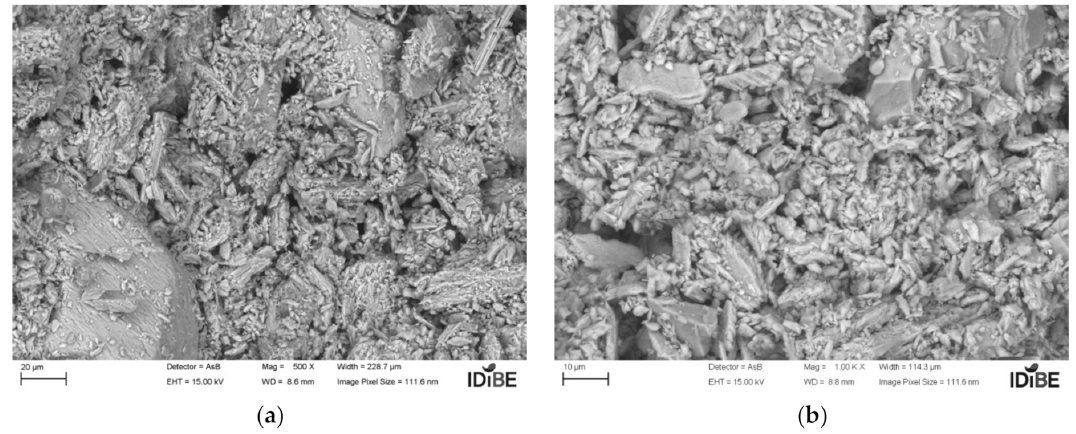
Figure 11. Micrograph of the 1.2% polycarbonate salt compound (lot TAR3): ( a ) 20 µ m; ( b ) 10 µ m (source: the author). Figures 12–14 show the micrographs of the mixtures of gypsum with polycarboxylates at dosages of 0.2%, 0.6%, and 1.2% of additive, respectively. The polycarboxylate changes its structure again via the formation of perfectly defined compact blocks.